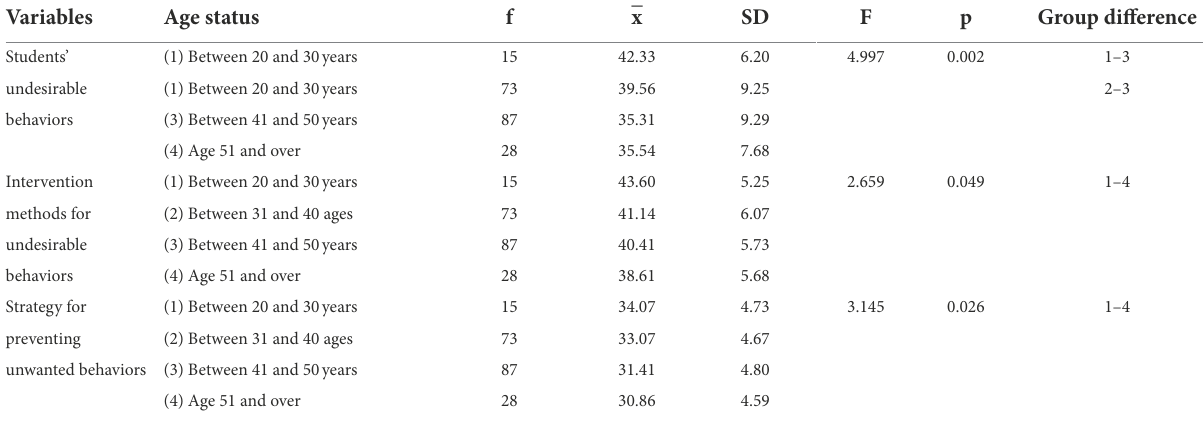
TABLE 3 Difference status of total scores obtained from variables by age.